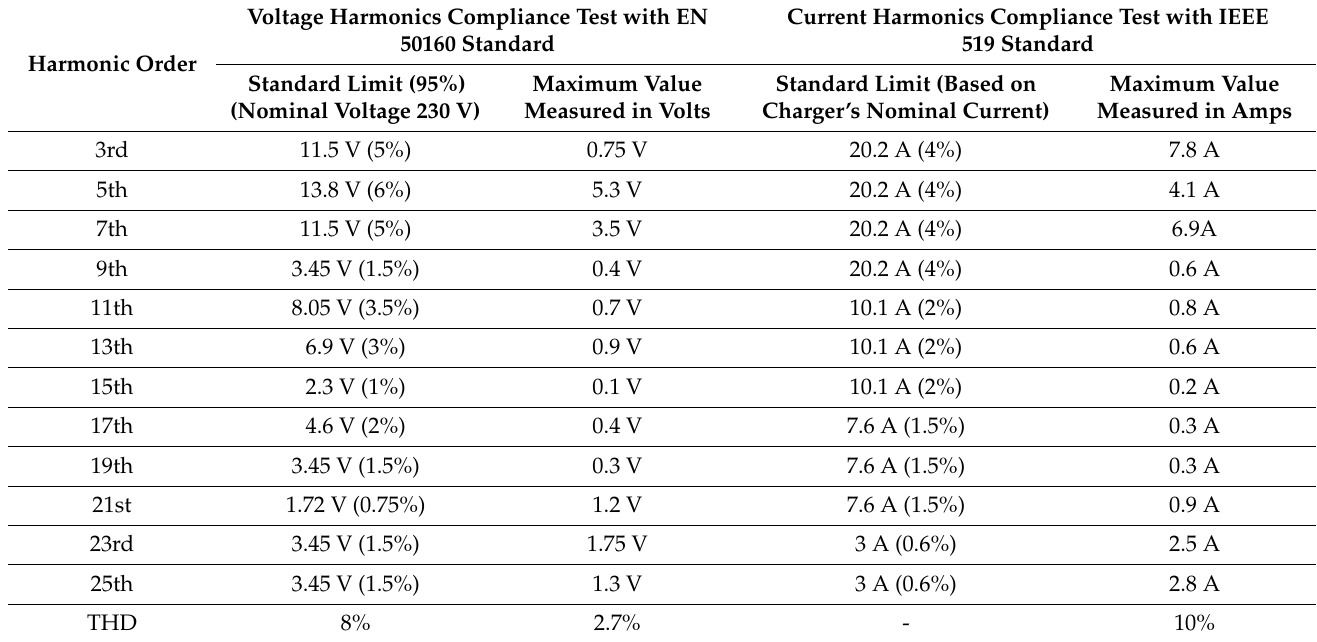
Table 6. Harmonics voltage and current emissions recorded at fast-charger terminal.